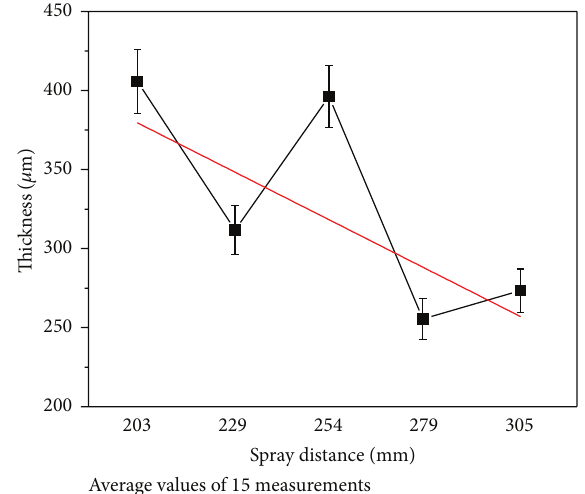
Figure 3: Co 32 Ni 21 Cr 8 Al 0.5 Y coating thickness according to the dif- ferent spray